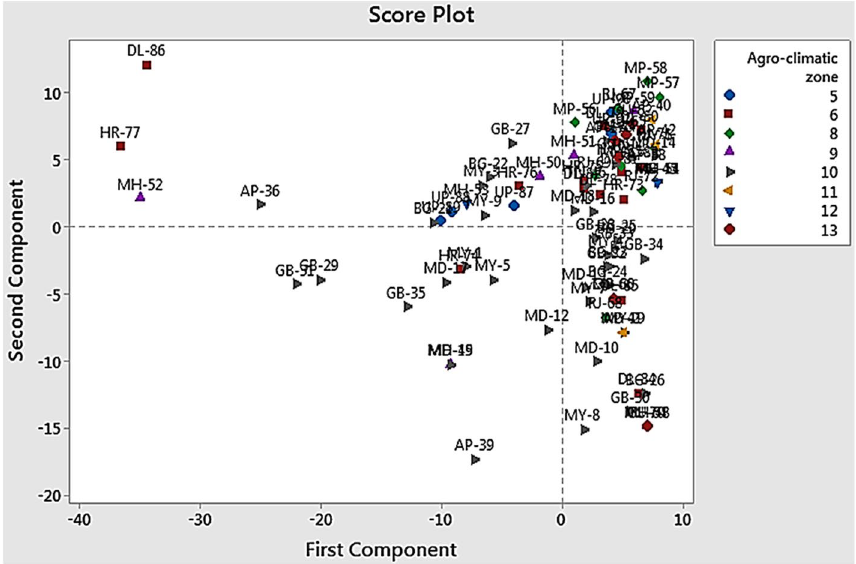
Figure 4. Principal component analysis of the distribution pattern of Trichoderma across different agroclimatic zones based on data generated through RAPD and ISSR analysis.